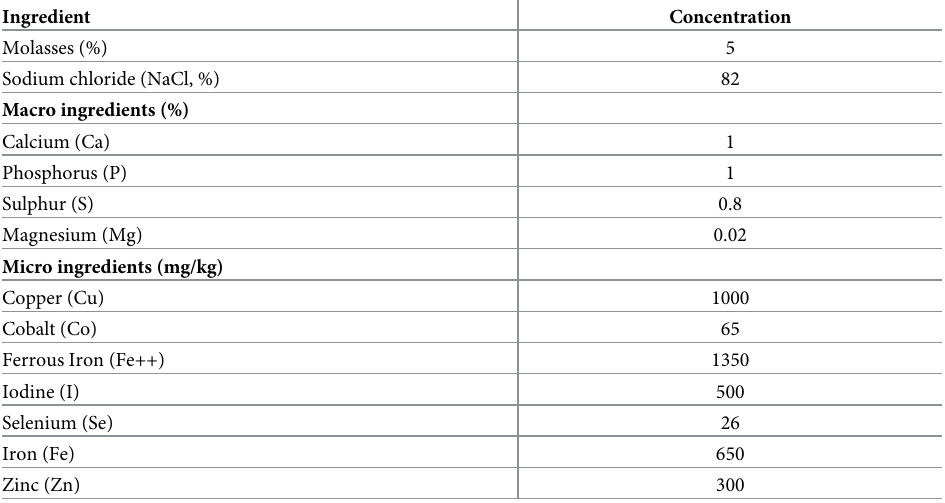
Table 1. Chemical composition of the mineral